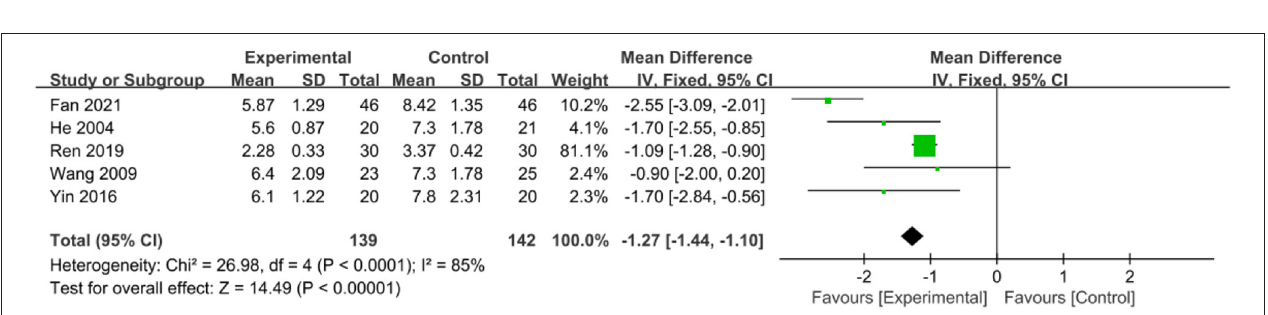
FIGURE 7 | Forest plots of total length of hospital stay associated with experimental group (parenteral or enteral nutrition group supplemented with Gln) vs. control group (conventional nutrition group). I 2 tests and P are the criteria for the heterogeneity test, (cid:7) , pooled mean difference; — (cid:4) —, mean difference, and the edges of (cid:7) , 95% CI.